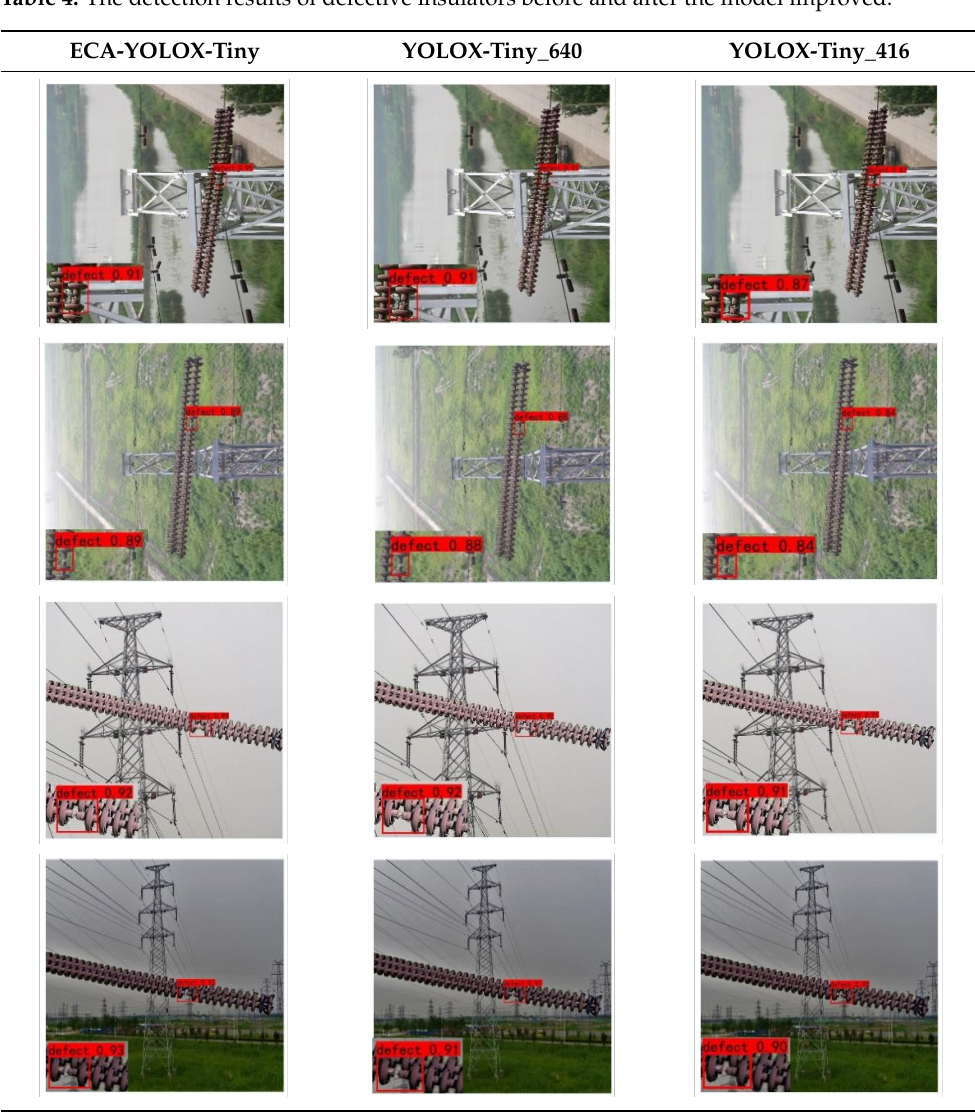
Table 4. The detection results of defective insulators before and after the model